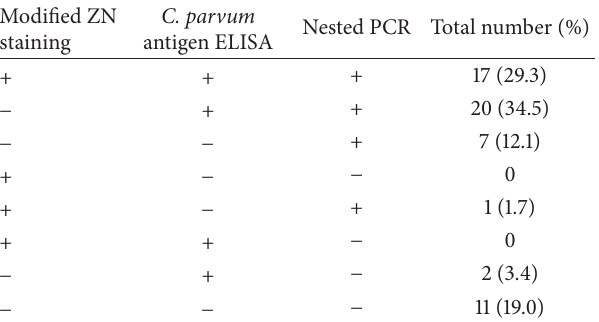
Table 2: C. parvum positivity in study subjects by one or more of the diagnostic modalities ( 𝑁 = 58 ).